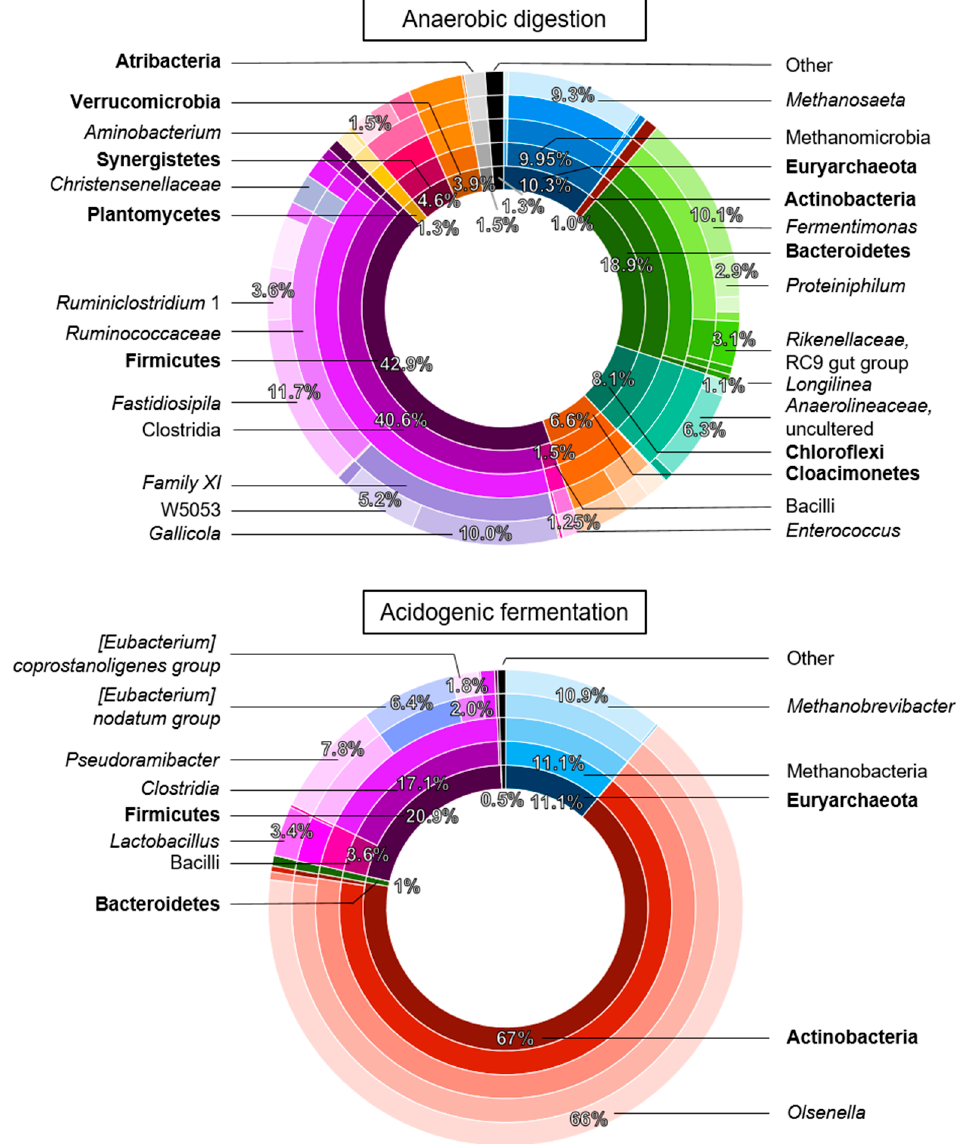
Figure 4. Taxonomic composition of the bacterial and archaeal community by the end of Phase 2: the anaerobic digestion reactor on Day 77 ( top ) and, the acidogenic fermentation reactor on Day 84 of operation ( bottom ). The concentric circles represent the taxonomic classification from phylum (bold, centre ring) to genus (outer ring), colours represent classification, and bandwidth and percentages relate to relative abundance.